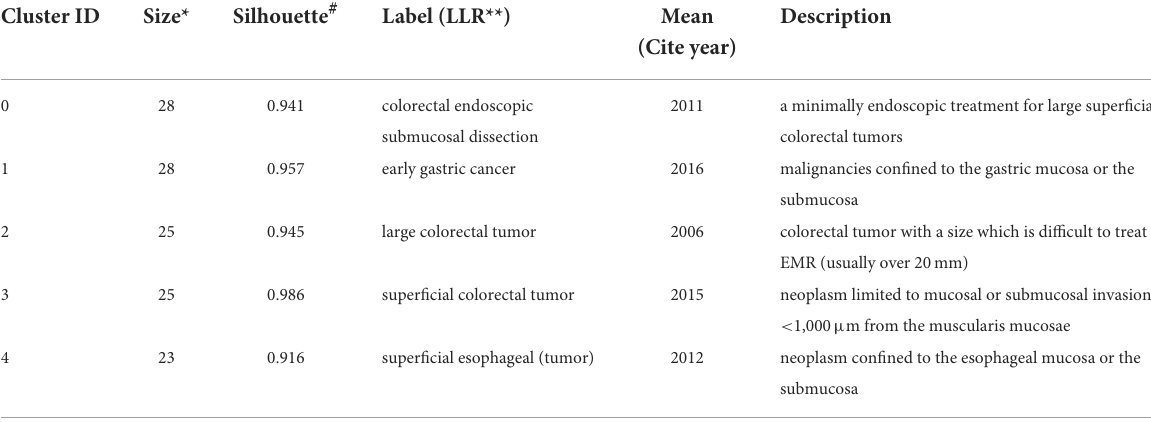
TABLE 4 Summary of the largest 5 clusters.